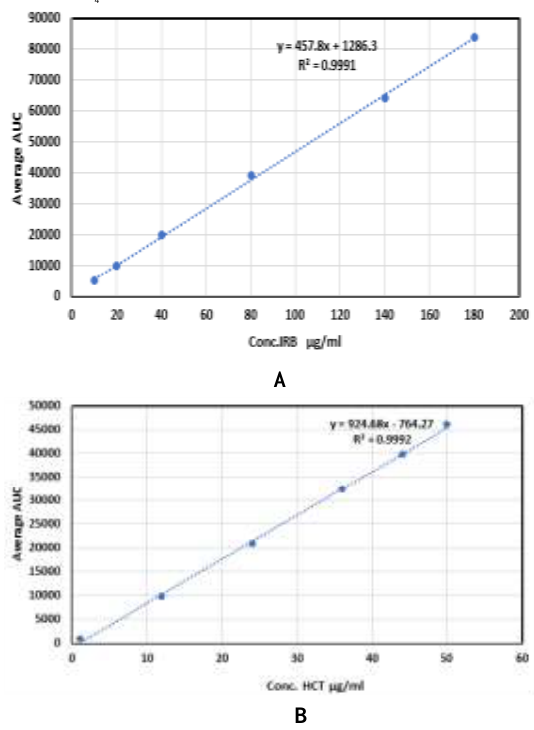
Figure 2. Calibration curves of Irbesartan (A) and Hydrochlorothiazide (B) Inter and intra-day precision results gave the mean value of percent accuracy between 97.7 - 101.1% for both IRB and HCT and the %RSD is below 2%, which means an accepted criterion according to the ICH guideline. Recovery of IRB from the formula was 99.3% with RSD 0.46 and that of HCT was 98.0 with RSD equals to